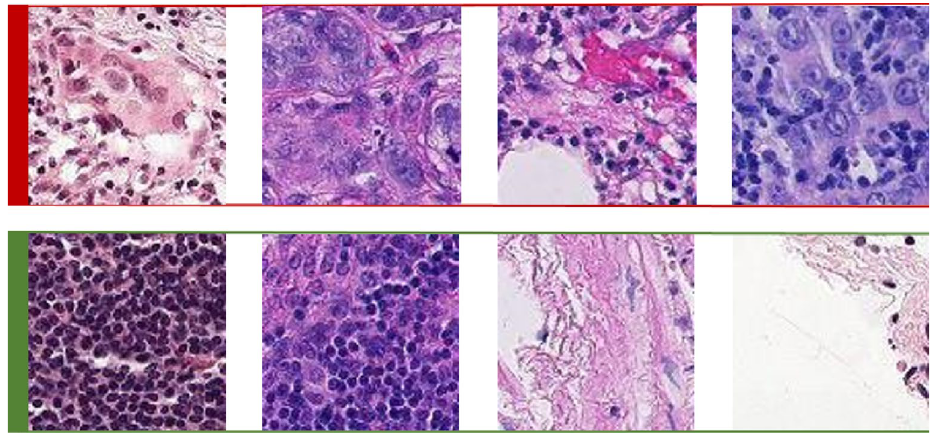
Figure 4. Two types of pathological findings for lymph node sections: red (1st row) and green (2nd row) annotated patches denote malignant and benign classes, respectively.